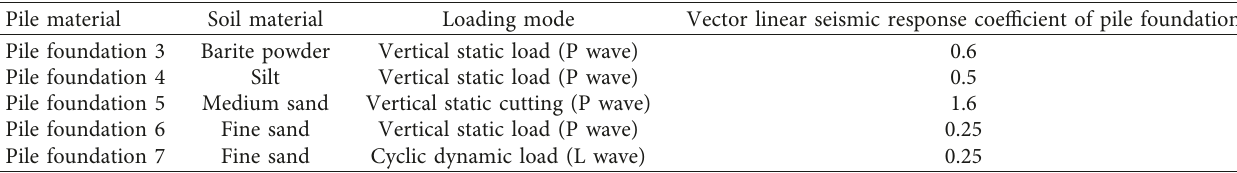
Table 2: Analysis of seismic response characteristics of single pile with different soil materials in Permafrost